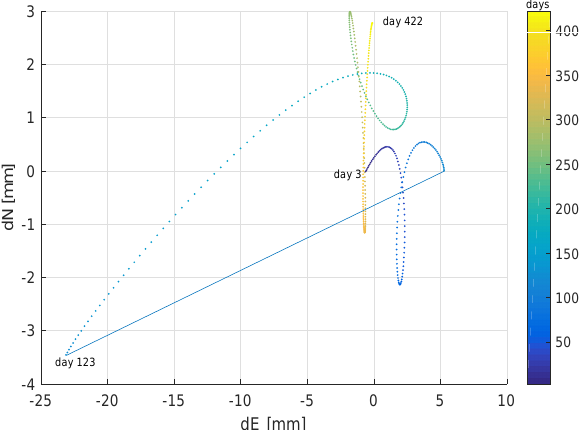
Figure 15. East-North 2D scatter of the modelled East point movements in the observed period